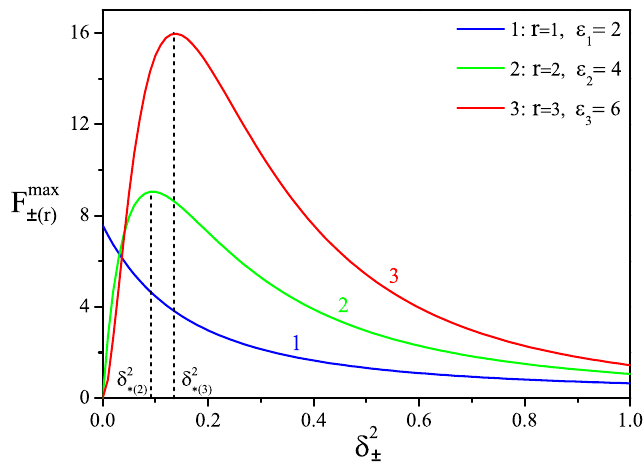
Figure 3. Dependences of the functions F max with the certain energy of the initial gamma quantum ω i = 500 MeV